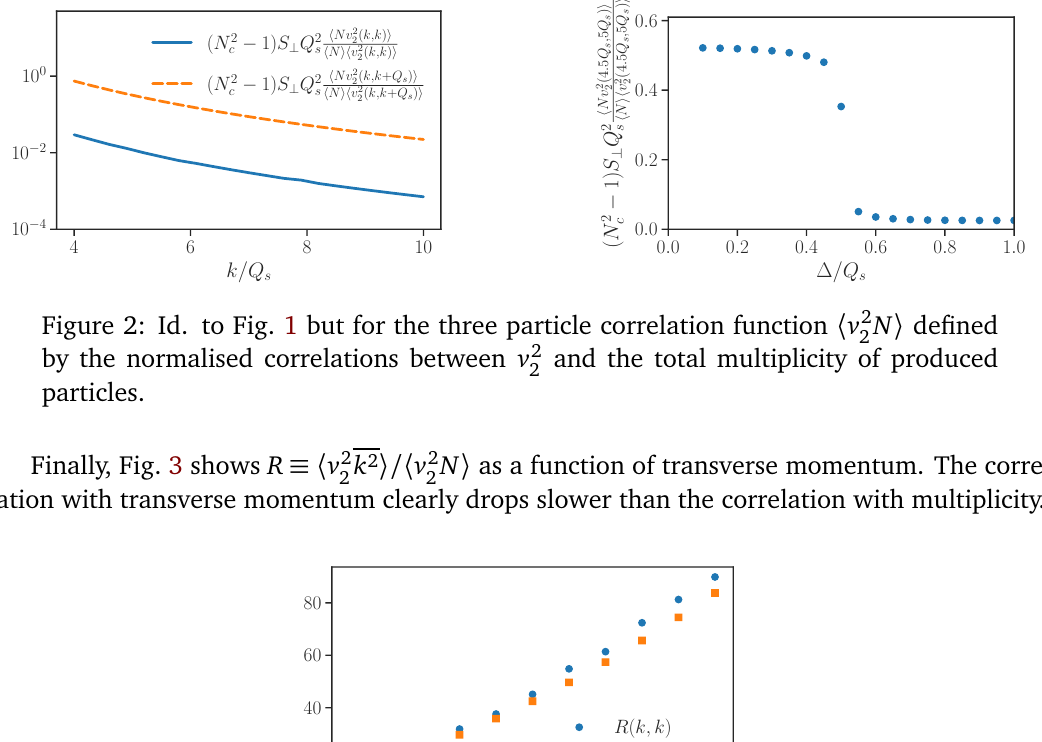
Figure 3: The ratio R ≡ 〈 v 2